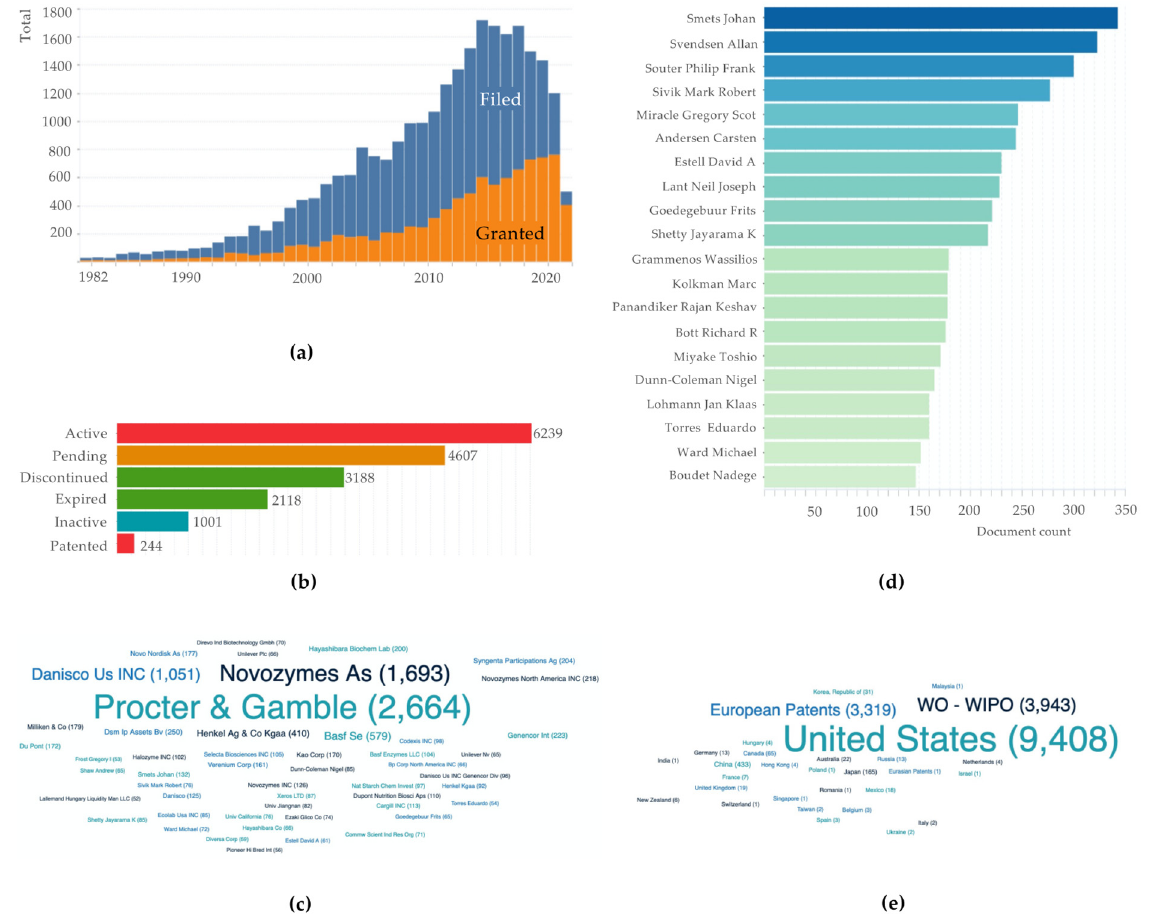
Figure 2. Bibliometric analysis of pullulan-degrading enzymes: ( a ) Patent documents by filed and granted date; ( b ) Patent documents by legal status; ( c ) Top 50 applicants; ( d ) Top 20 inventors; and